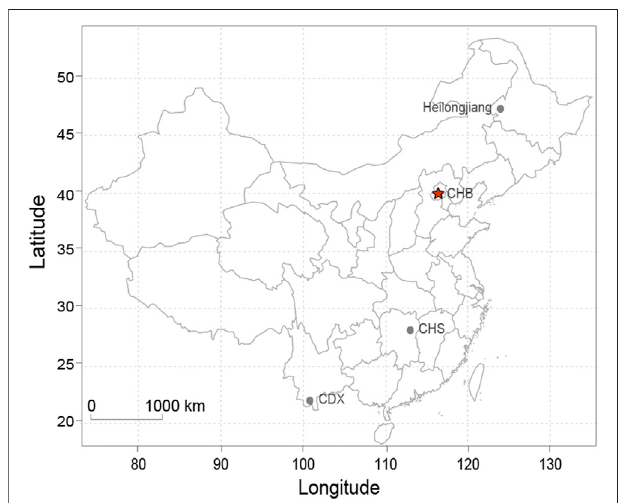
FIGURE 1 | The geographical distribution of eight ethnic groups in China.Note:CHB:HanChineseinBeijing;CHS:SouthernHanChinese;CDX: Chinese Dai in